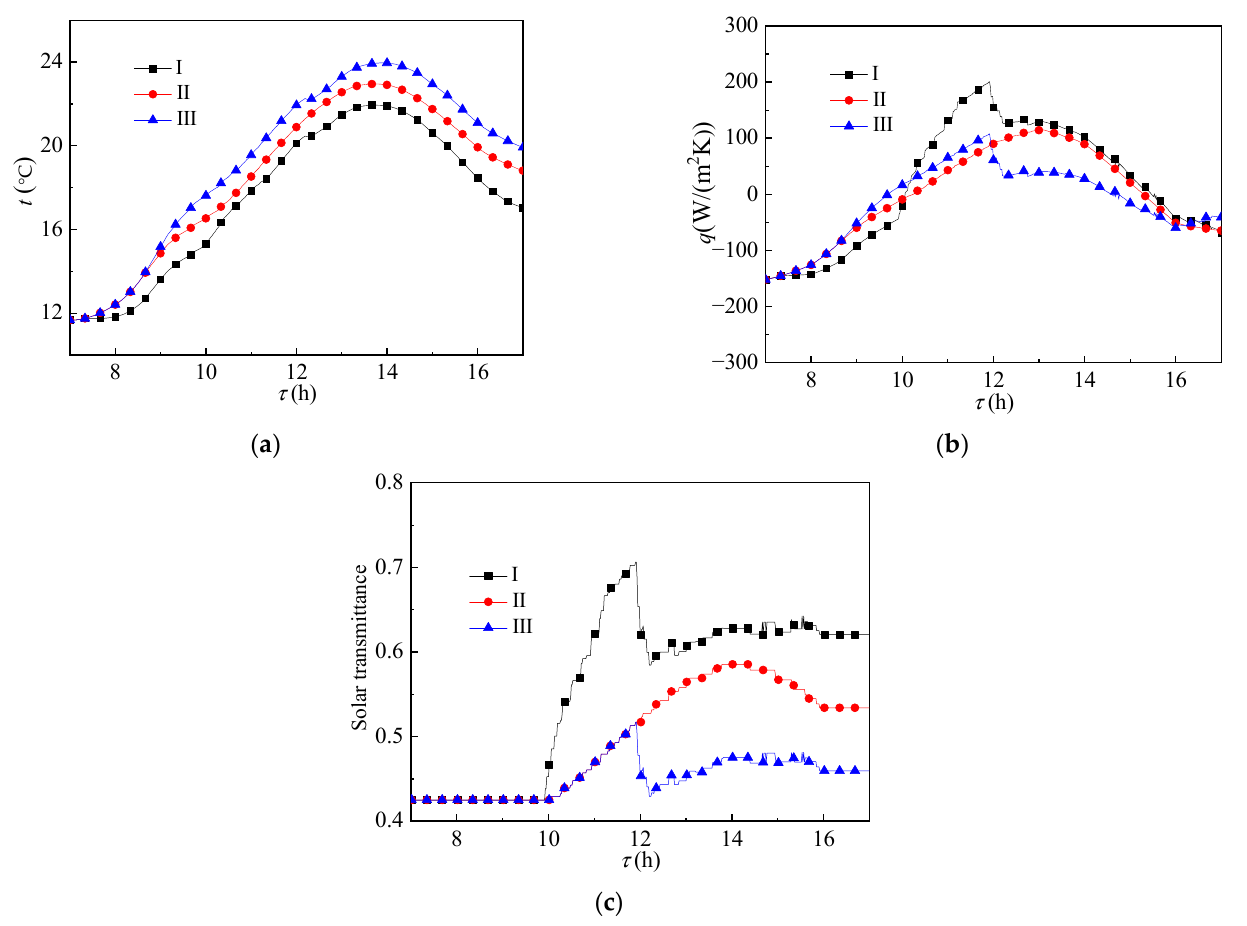
Figure 7. Change of ( a ) temperature, ( b ) heat flux, and ( c ) solar transmittance of the glass envelope over time.